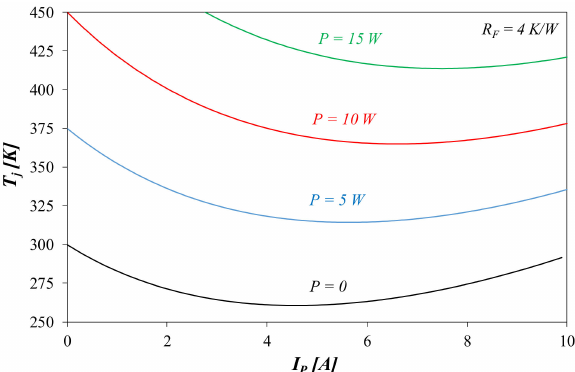
Figure 9. Device junction temperature versus the current I p at selected values of power dissipated.